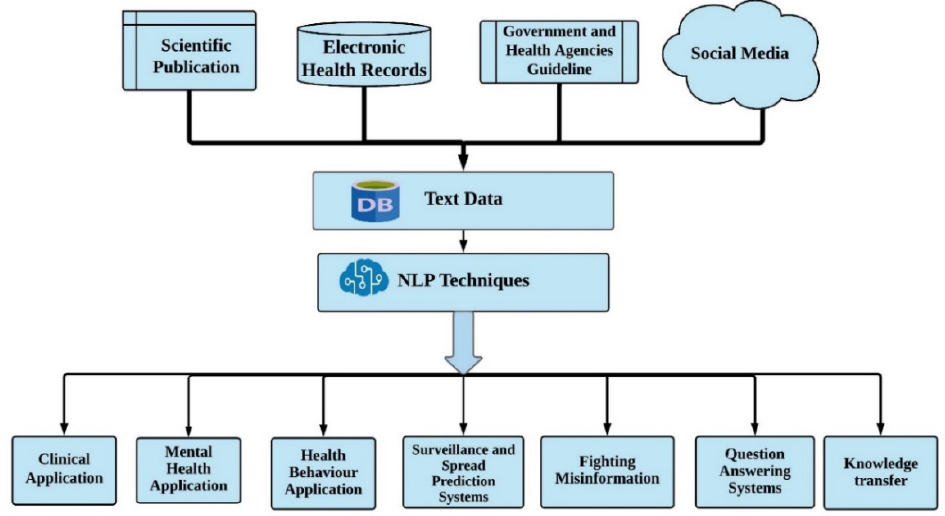
Figure 2. Summary of applications of NLP methods for COVID-19 reviewed in this paper. Distinct information sources are shown at the top.